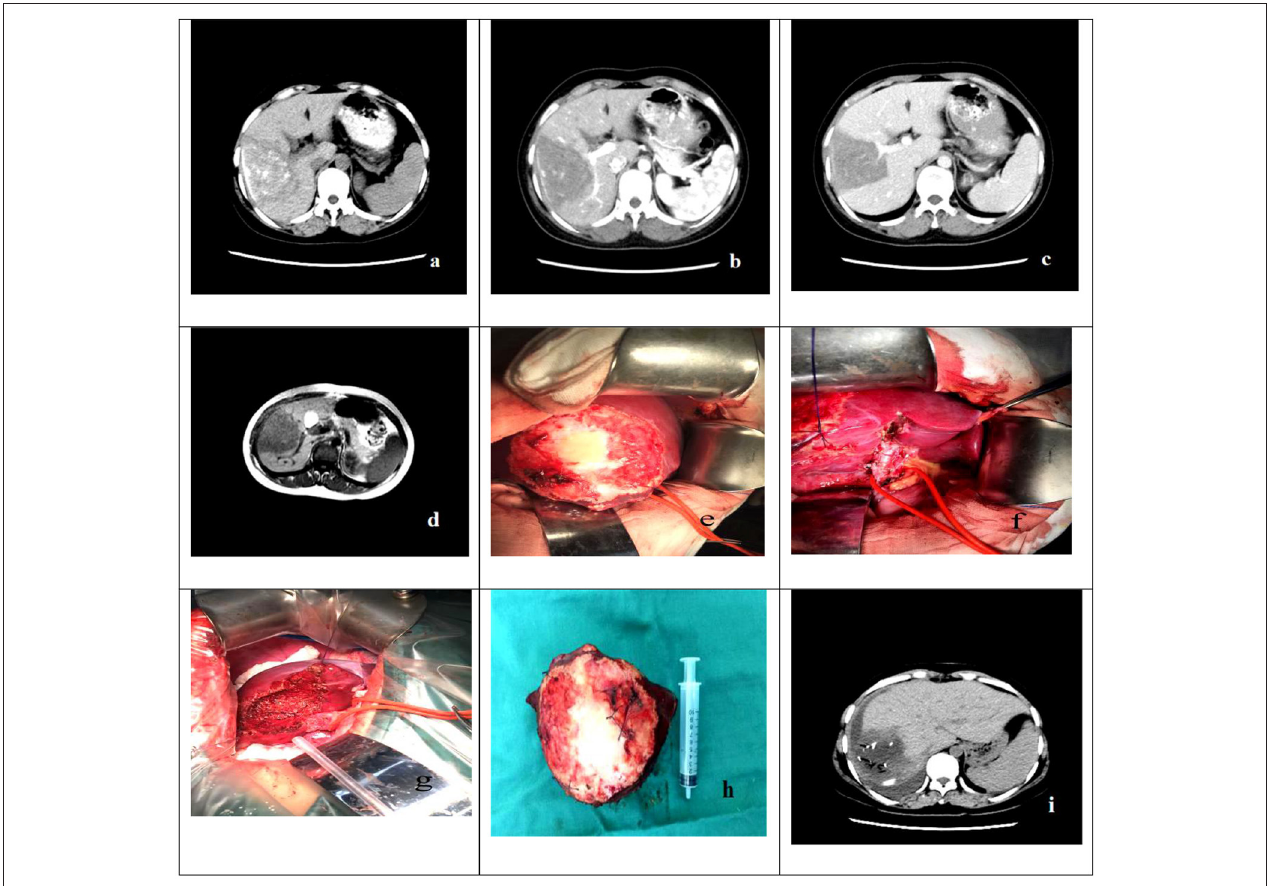
FIGURE 2 | The case is a 22-year-old male patient who was hospitalized due to the chief complaint of “liver space-occupying lesions found in physical examination for more than 1 year”. (a–d) Preoperative abdominal CT and abdominal MRI of patient showed that there was a lesions of echinococcosis in the liver with the size of about 8.0 out.0cm in S5-6 segments. (e–h) The Intraoperative resection and postoperative pathological specimens. (i) The abdominal CT showed that there was residual liver compensatory and hyperplasia, but there was no recurrence of